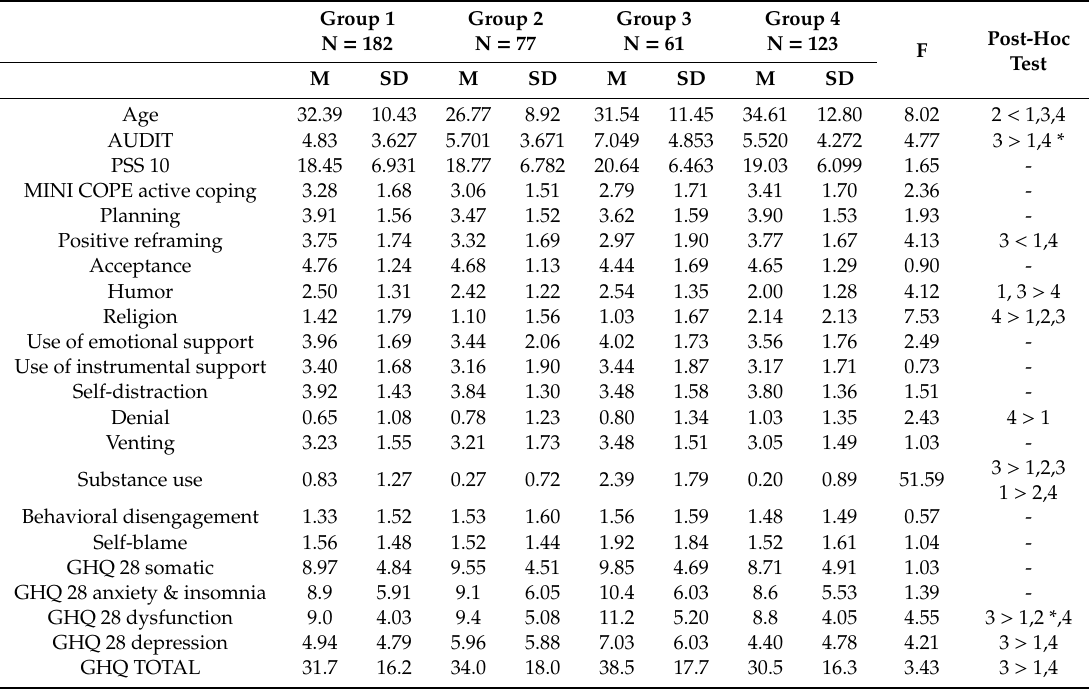
Table 3. A comparison of drinking patterns in subjects during the